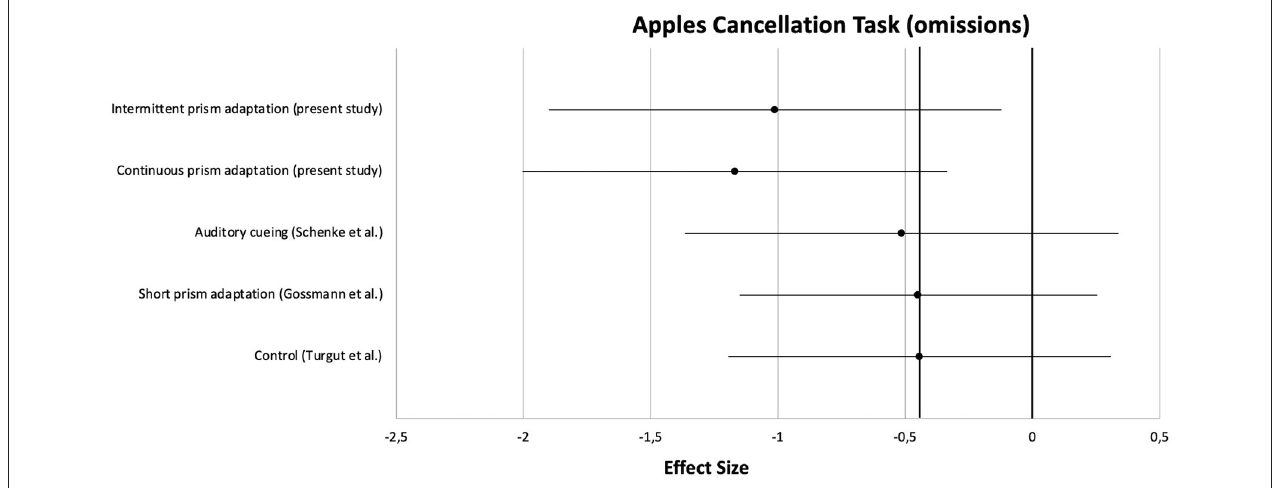
FIGURE 5 | Comparison of effect sizes of the present prism adaptation treatment protocols and previous studies on neglect interventions for the Apples Cancellation